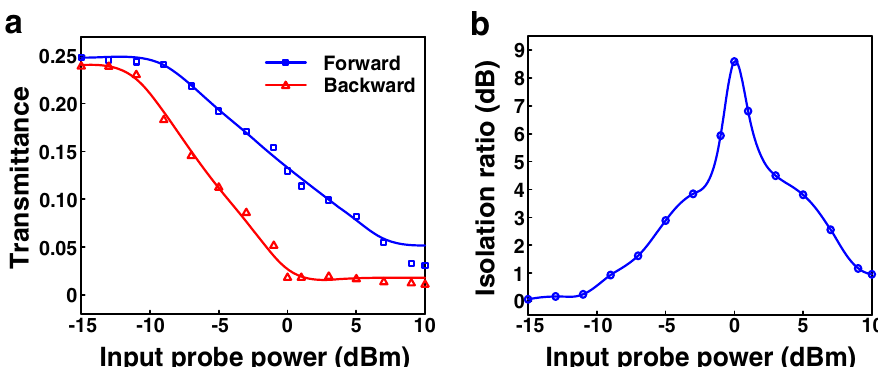
Fig. 5 Isolation performance. Experimental results of the isolation performance in the broken-PT-symmetric FP resonators. a . The transmittances of the probe signal entering the device in the forward (blue squares) and backward (red triangles) propagation directions, measured as a function of the probe power when the pumping power and the coupling strength are fi xed. b . The isolation ratio as a function of the probe